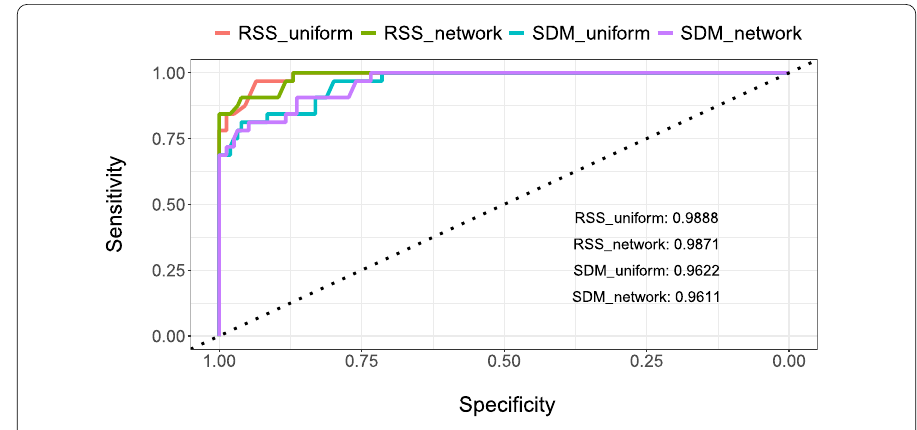
Figure 8 ROC curves for the duplicity probabilities p (2) p (2) = 1 – p (1) computed according to eq. (9) for HMMs with two priors and two emission models d d